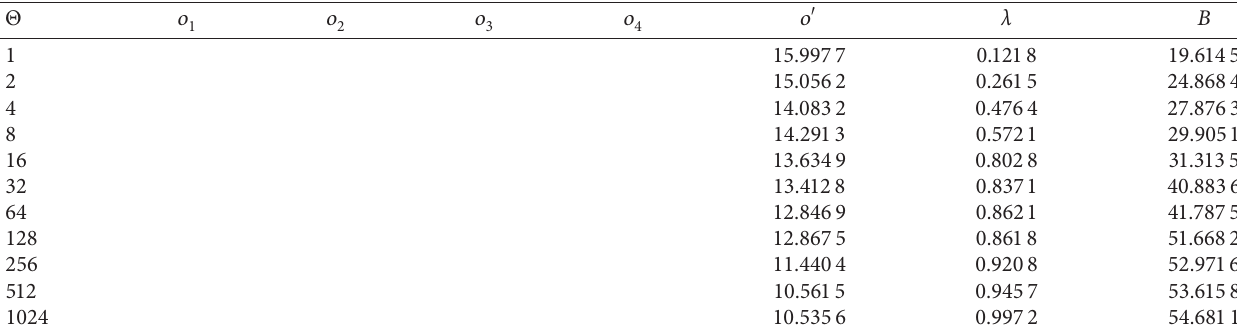
Table 5: Result of model